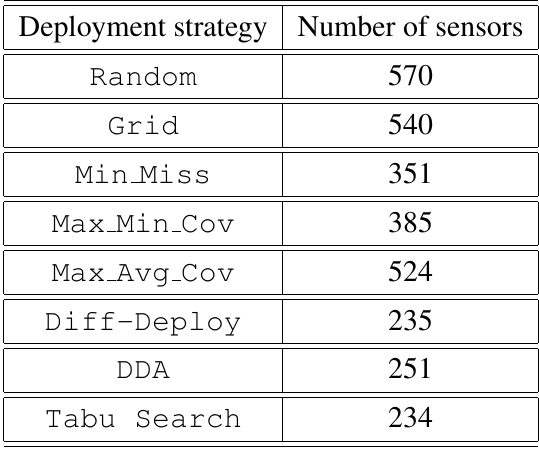
Table 1. Number of deployed sensors to reach 97 . 10% of satisfaction